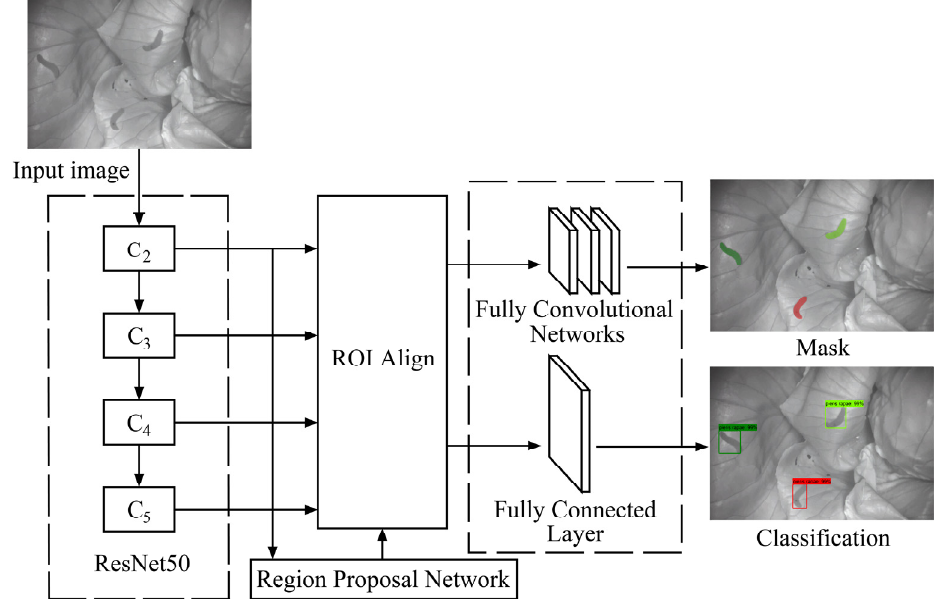
Figure 4. Overall Mask R-CNN with the ResNet50 model structure.